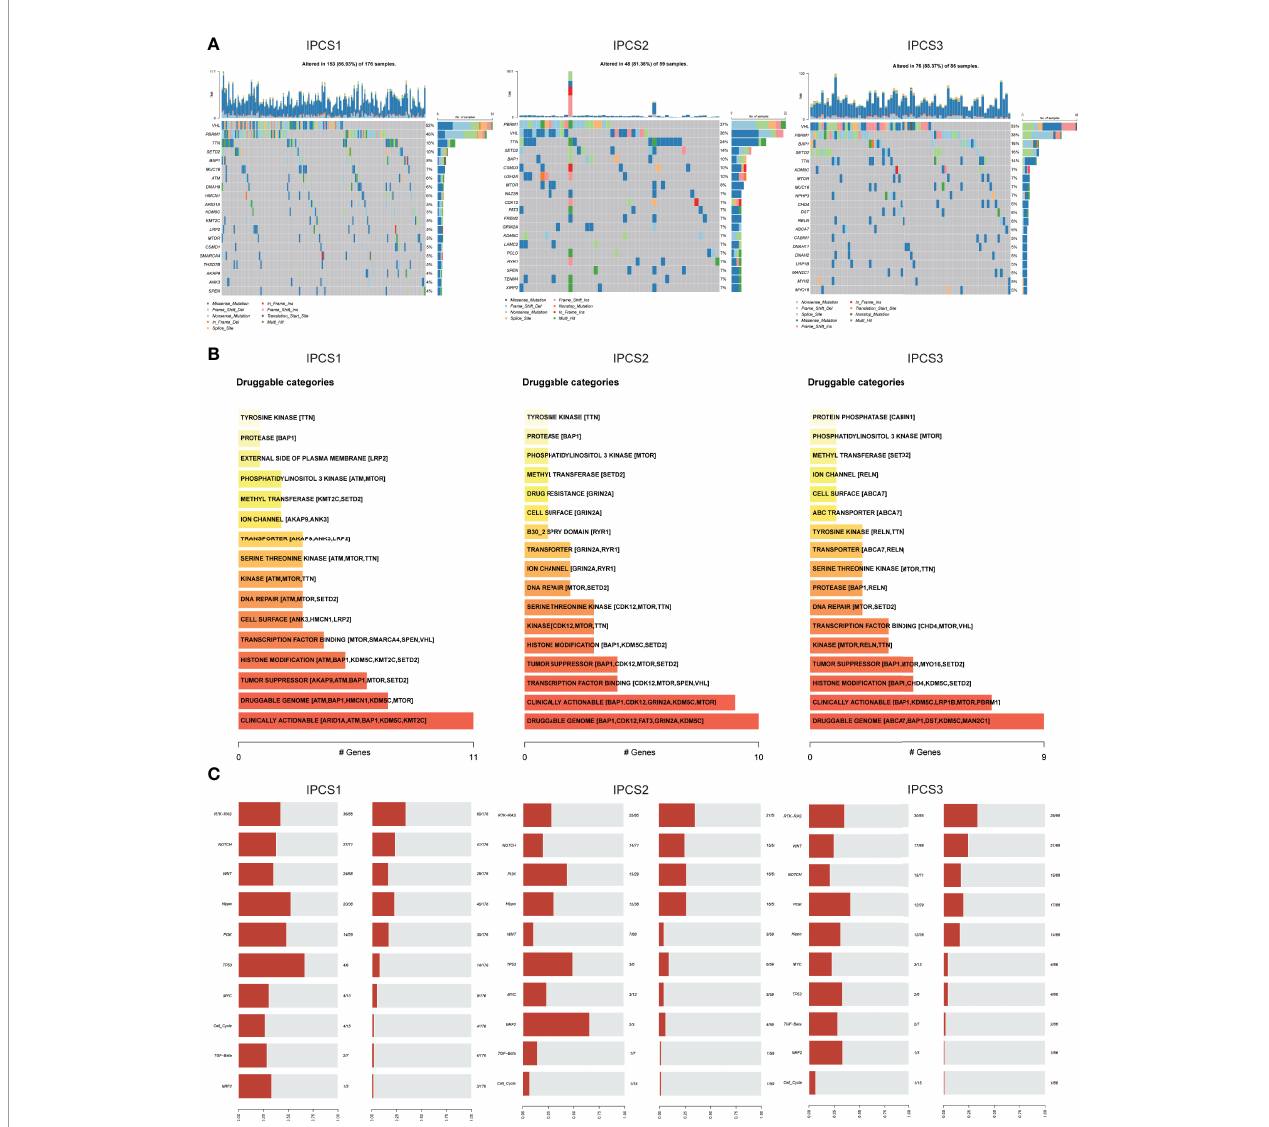
FIGURE 6 | Pro fi les of somatic mutations and potential targets among the three subtypes. (A) Waterfall plot showing the mutation patterns of the top 20 most frequently mutated genes. (B) Potential druggable gene categories from mutation dataset among IPCS1, IPCS2, and IPCS3. (C) The fraction of pathways or samples of oncogenic signaling pathways among IPCS1, IPCS2, and